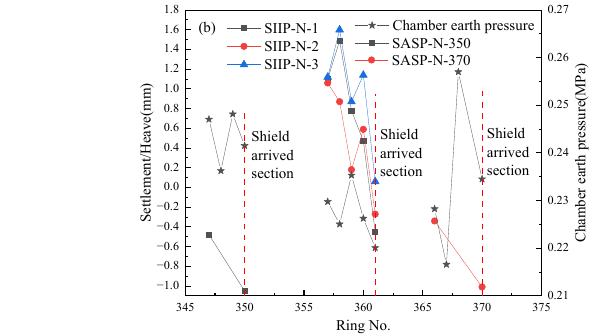
Figure 17. The relationship between chamber earth pressure and surface deformation: ( a ) south line; ( b ) north line.